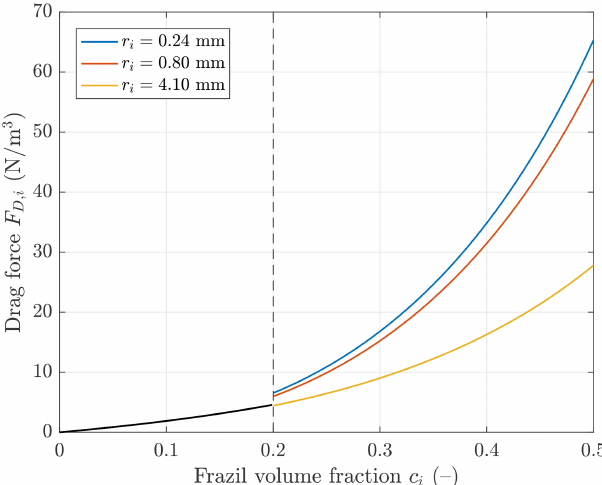
Figure 4. Drag force F D ,i induced by the vertical motion of frazil crystals in function of frazil volume fraction c i . For c i < 0 . 2, F D ,i is independent of frazil size (black curve). For c i > 0 . 2, three curves are shown corresponding to the three values of frazil radius r i used in the simulations discussed in this paper (see also circle symbols in Fig.